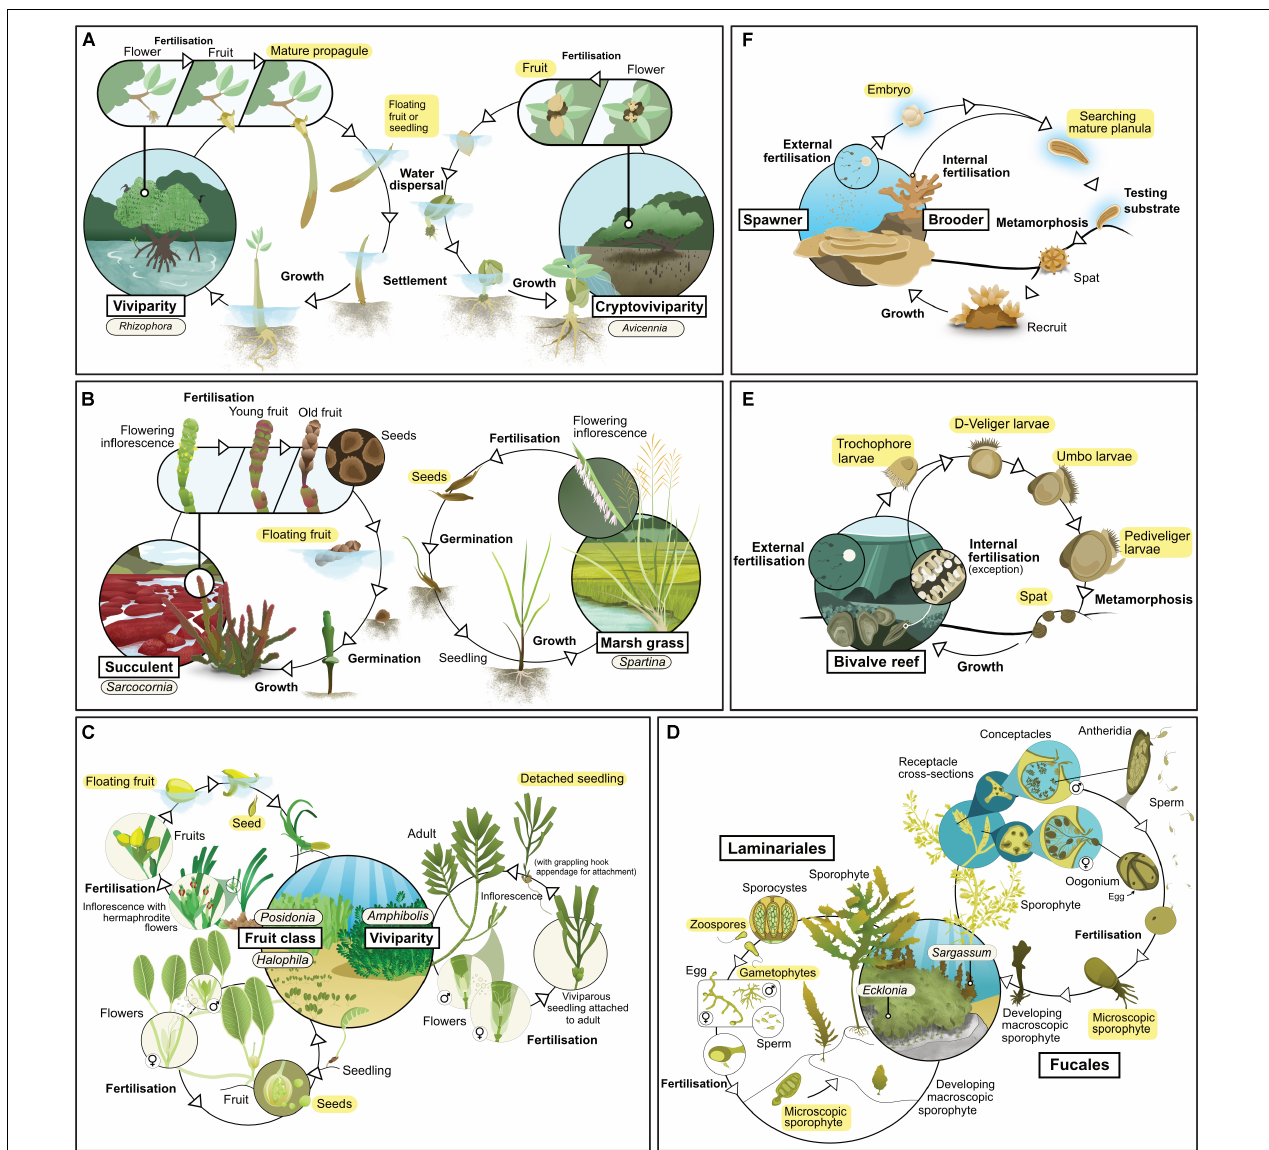
FIGURE 1 | Life history of the main habitat-forming taxa for each of six coastal ecosystem types: (A) mangrove, (B) tidal marsh, (C) seagrass, (D) kelp, (E) coral reef, (F) bivalve reef. Text highlighted in yellow indicates life stages considered as propagules in this